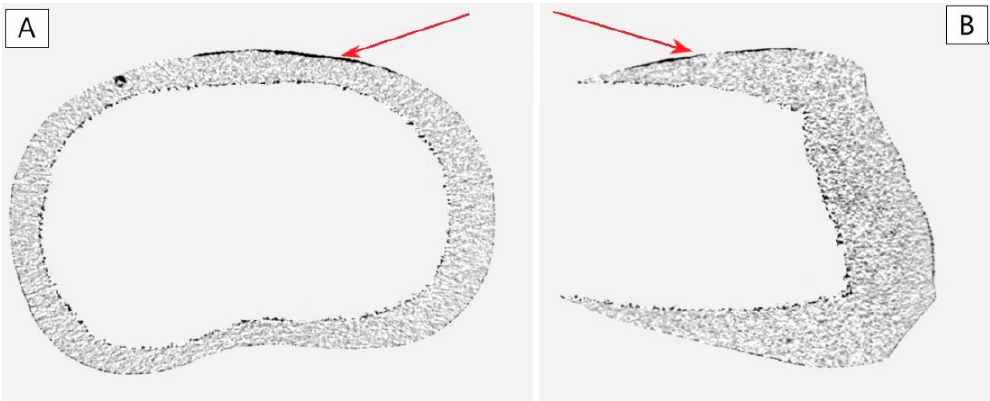
Figure 6. Example cross-sections (transverse and sagittal) of G1 group tooth, showing lesions in the enamel after laser conditioning (black). ( A ) Cross-section in the transverse plane; ( B ) cross-section in the sagittal plane. Pictures obtained using the DataViewer software (SkyScan 1172, Bruker, Kontich,